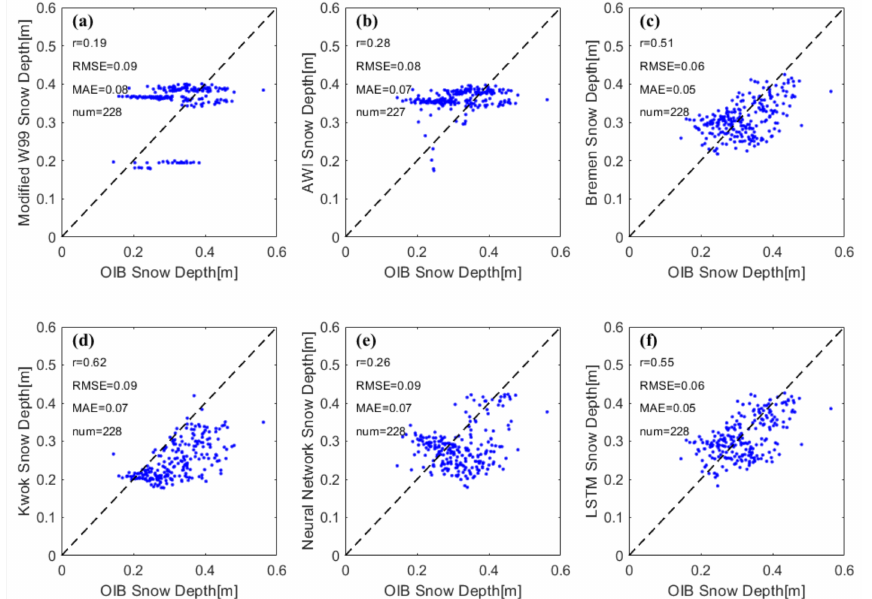
Figure 9. Scatterplots of different snow depth products and OIB snow depth: ( a ) modified W99 snow depth, ( b ) AWI snow depth, ( c ) Bremen snow depth, ( d ) Kwok snow depth, ( e ) Neural Network snow depth, ( f ) LSTM snow depth. The black line is the relationship with each other.